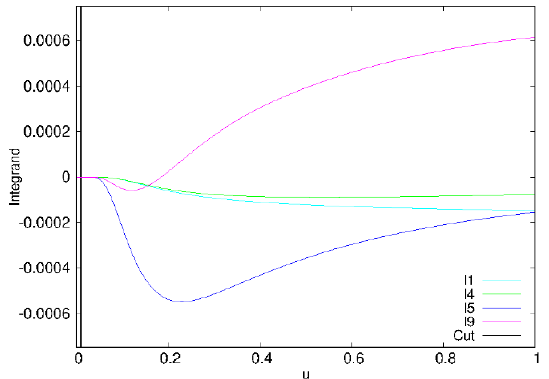
Figure 11. We display several examples of the pro(cid:12)le of the integrand as a function of u near ( s; u; v ) = (2 ; 0 ; 0) for several integrals for c = 0 : 7, to illustrate that the cut introduced in u (displayed as a vertical line near the origin) has no e(cid:11)ect on the